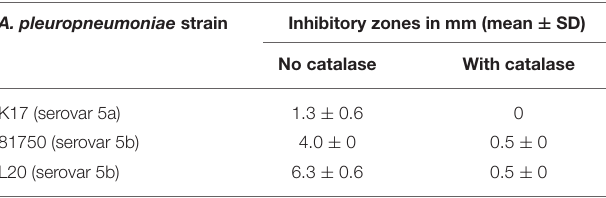
TABLE 2 | Inhibitory zones produced by S. pluranimalium 2N12 against A. pleuropneumoniae in a deferred growth inhibition